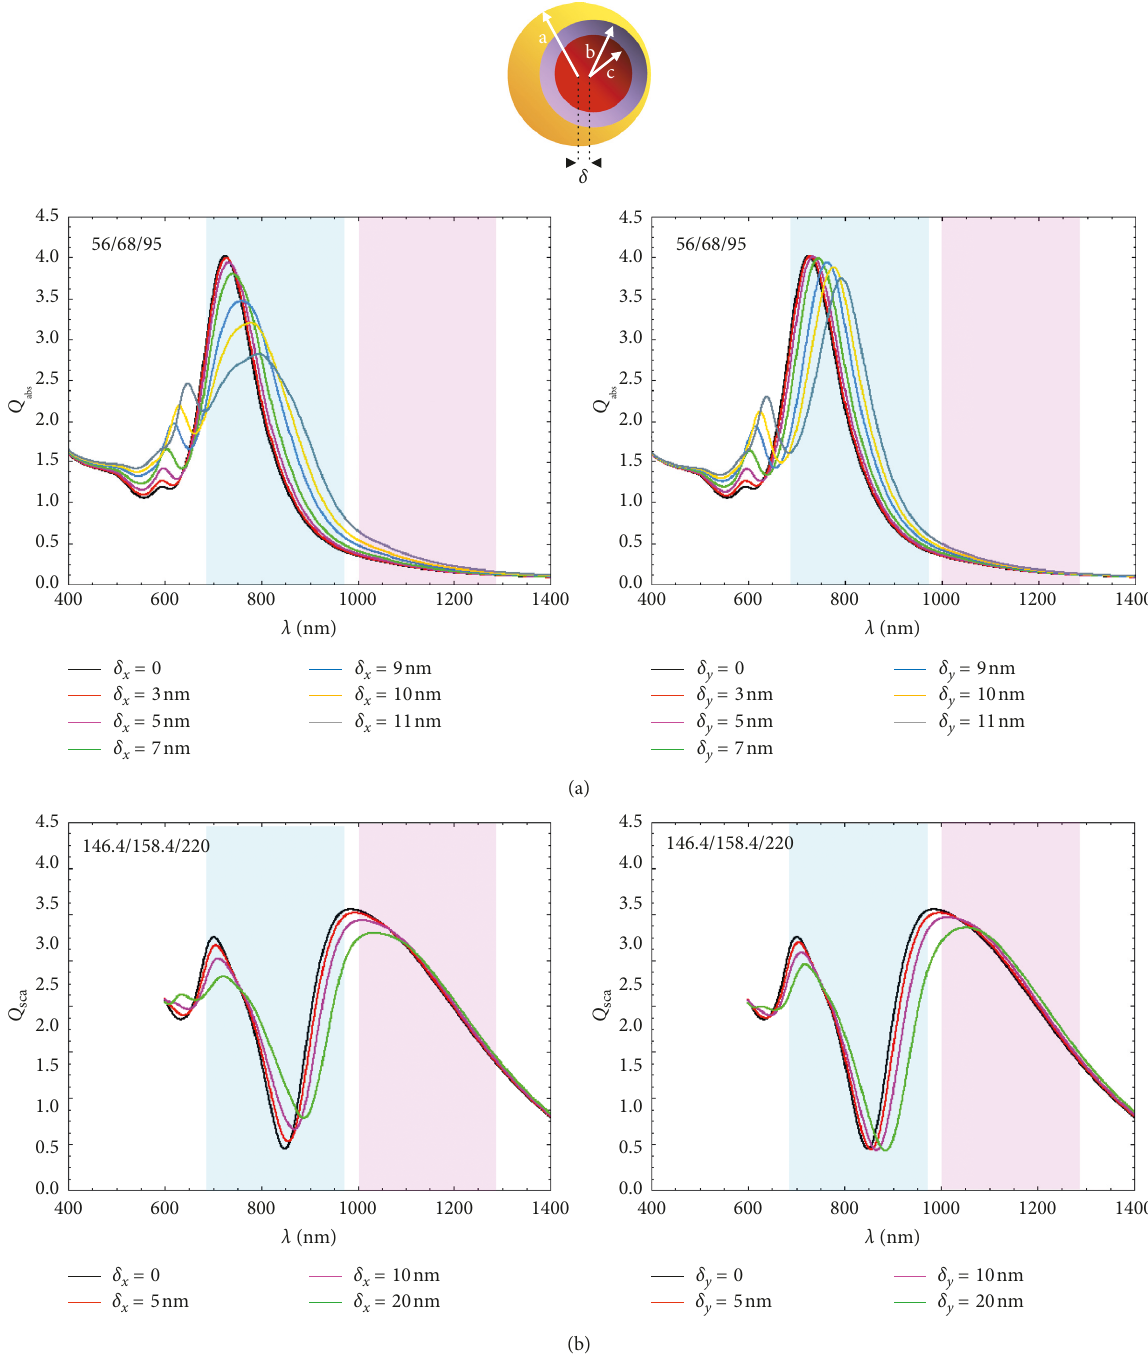
Figure 8: The absorption efficiency Q abs (a) and scattering efficiency Q sca (b) of a single Si/SiO 2 /Au eccentric multishell in biological tissues as a function of the incident light wavelength λ for different values of the gold shell